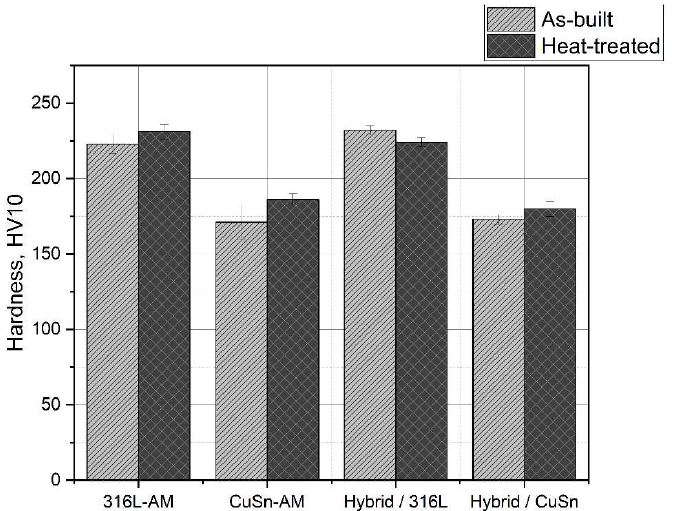
Figure 6. Overview of the hardness values. Table 4. Determined characteristic values of the LSV investigations.